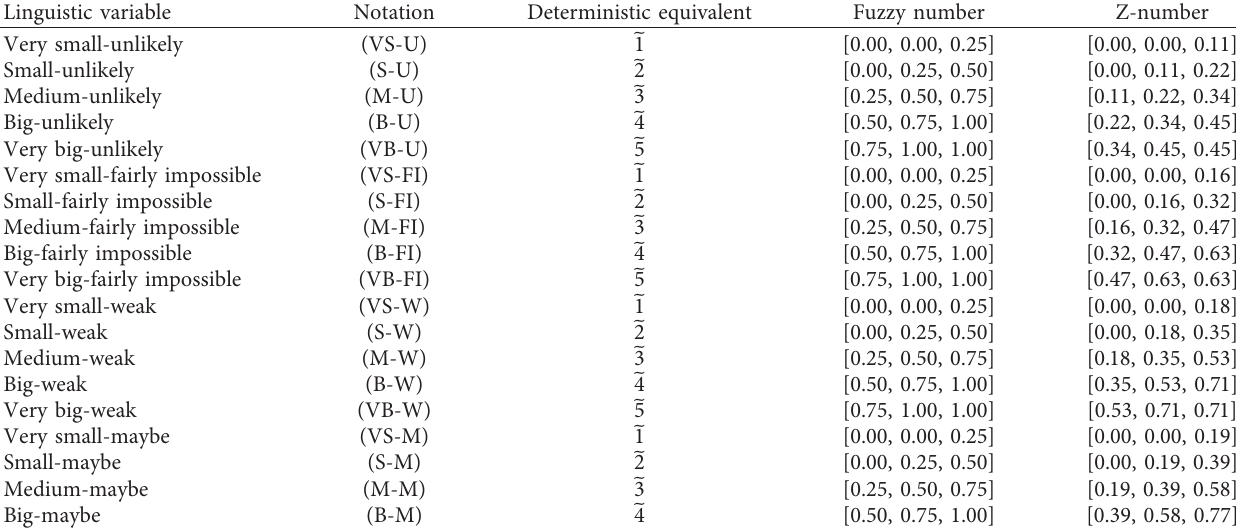
Table 7: The linguistic variables used and their corresponding